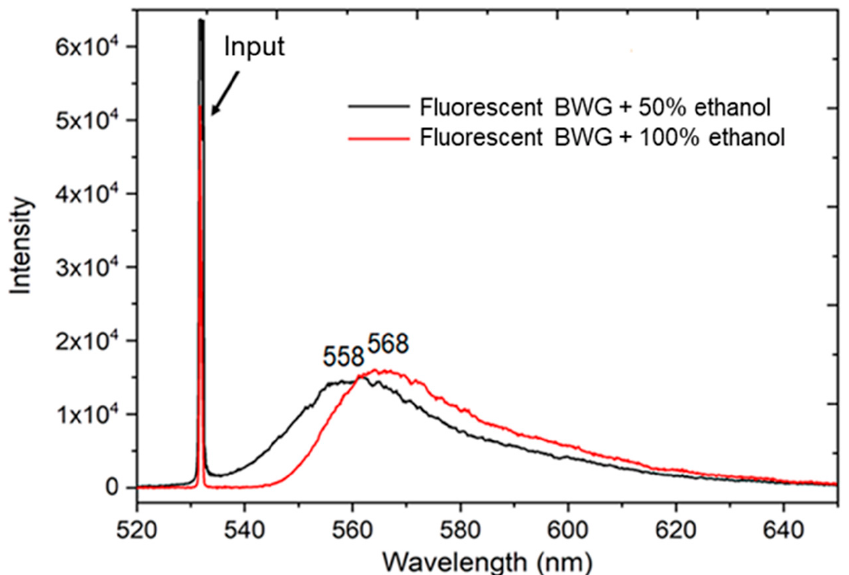
Figure 7. The spectra of laser radiation transmitted through the BWG: red curve corresponds to 100% ethanol deposited on the PG surface, while black curve corresponds to 50% ethanol solution. Input radiation is 531.7 nm with power ~3.0 mW.